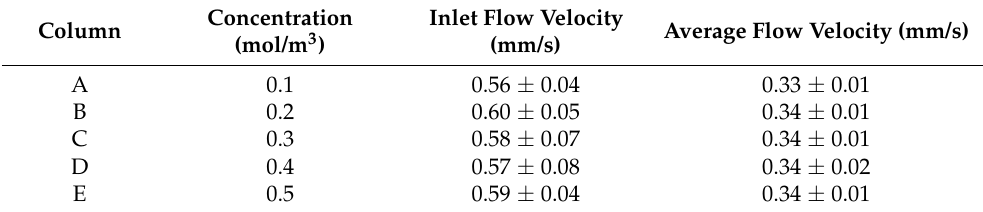
Table 2. The flow velocity of each polyp culture